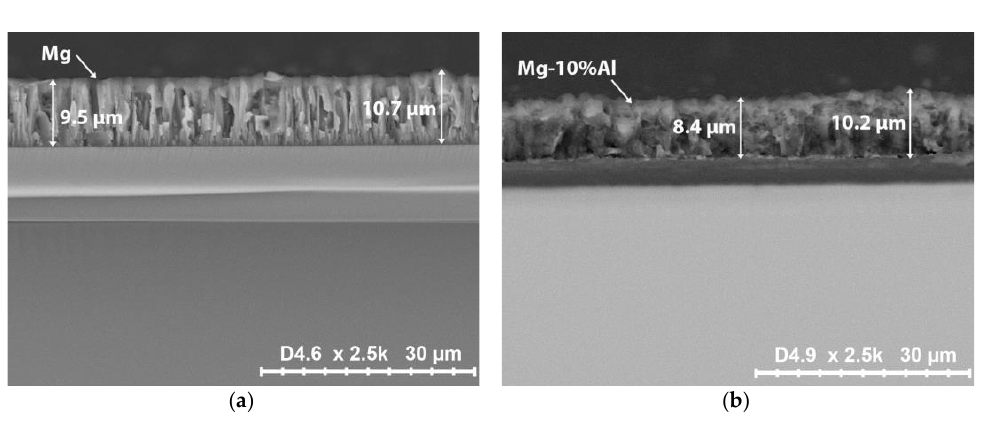
Figure 4. SEM images of a transverse cleavage of ( a ) Mg coating; ( b ) Mg-10%Al coating.